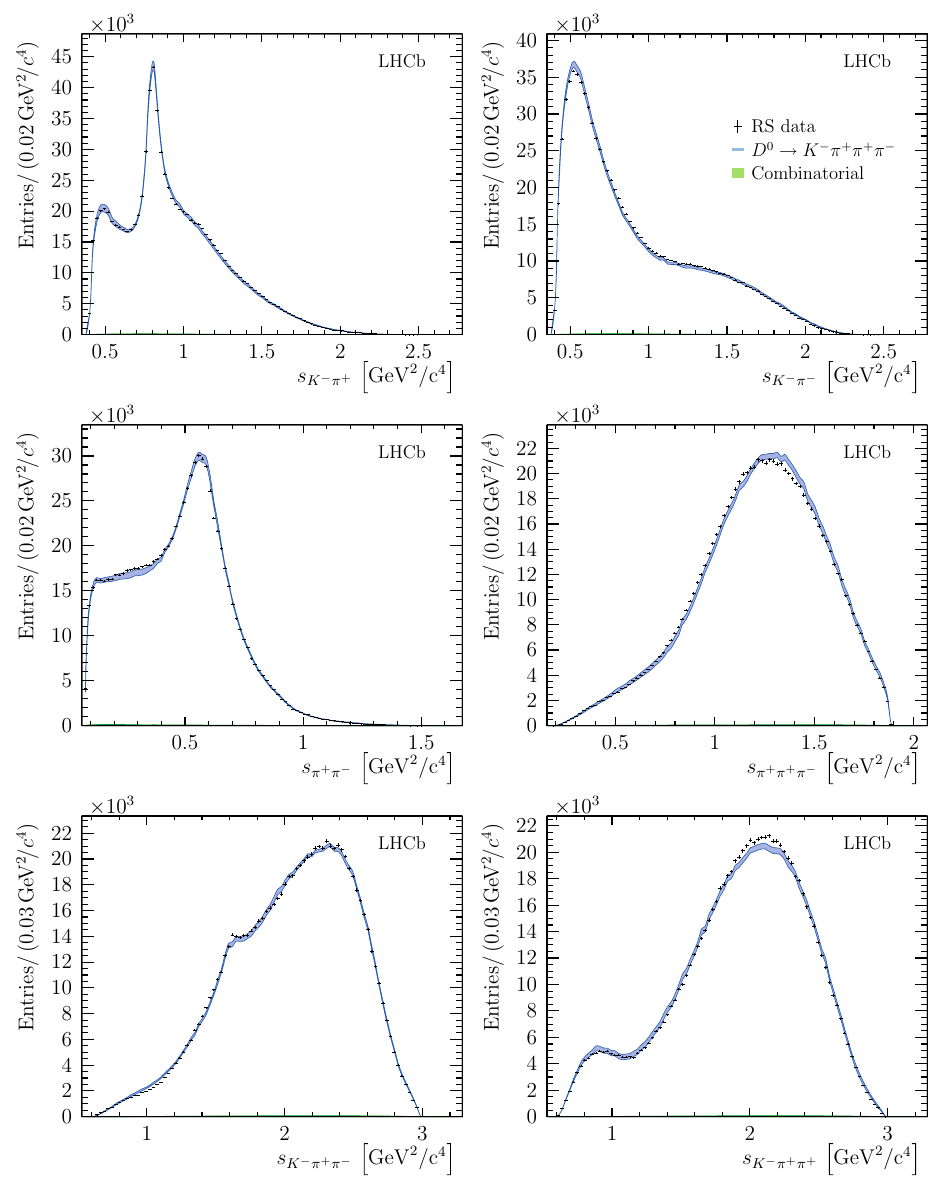
Fig. 2 Distributionsforsixinvariant-massobservablesintheRSdecay D 0 → K − π + π + π − . Bands indicate the expectation from the model, with the width of the band indicating the total systematic